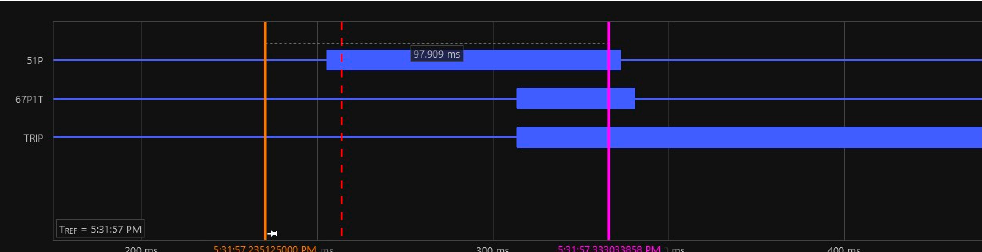
Figure 35. Trip logic and trip signal recorded by R1 under definite-time scheme.